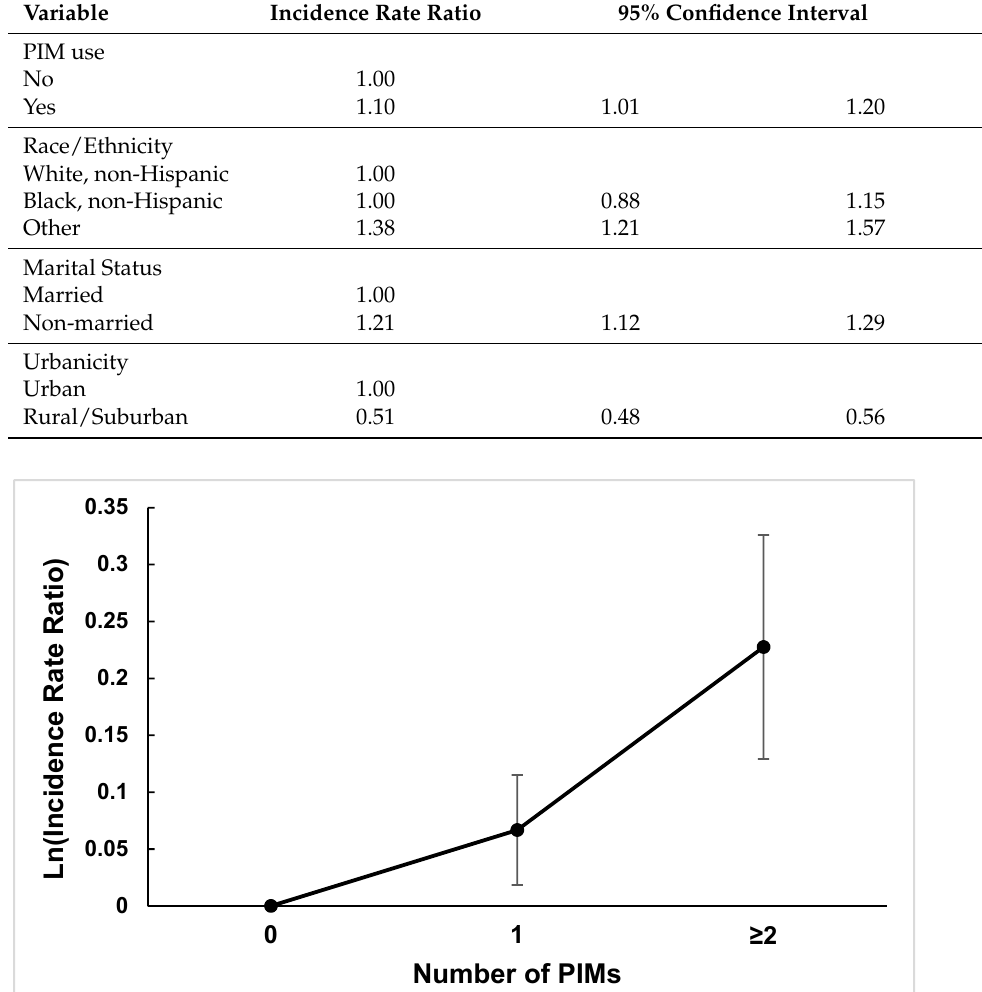
Table 2. Estimated incidence rate ratios and 95% confidence intervals of hard braking events from the multivariable negative binomial model according to potentially inappropriate medication (PIM) Use, race/ethnicity, marital status and urbanicity, the Longitudinal Research on Aging Drivers (LongROAD) Study.